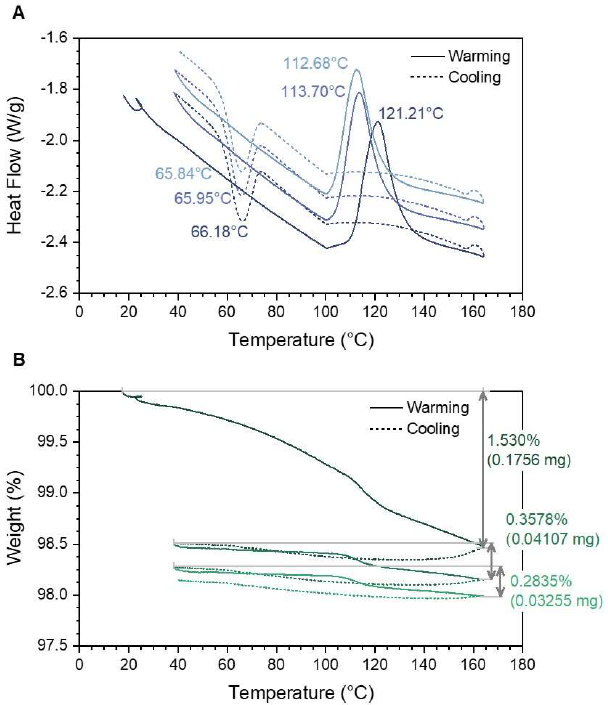
Figure 6. TGA and DSC data on [Fe(Htrz) 2 (trz)](BF 4 )] bulk samples that did not have any Tergitol NP9 present in the synthesis. ( A ) DSC data show higher temperatures for the transition from low spin to high spin when compared to nanoparticles in all three thermal cycles. ( B ) Weight loss for the bulk sample shows that less weight is lost in the three thermal cycles when compared to the nanoparticles.